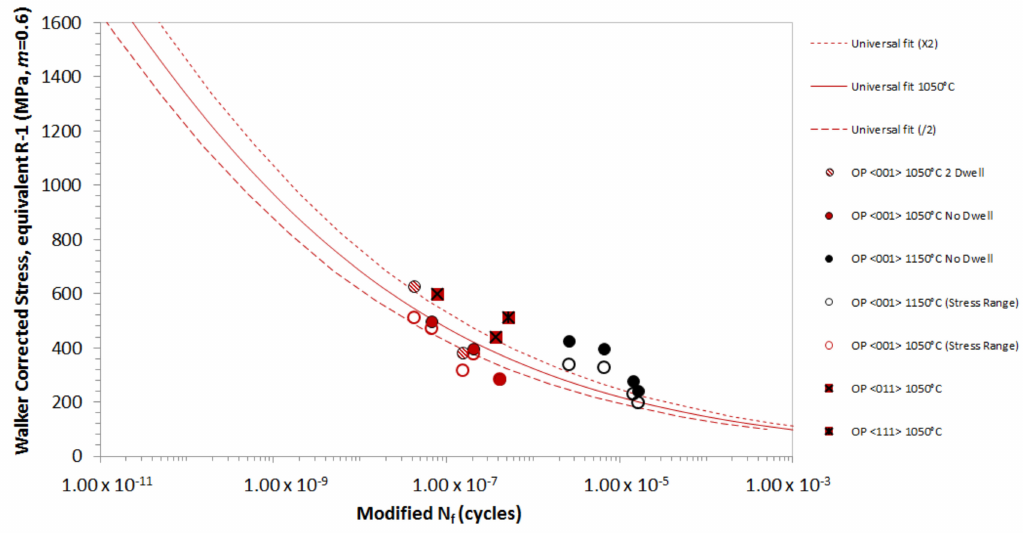
Figure 7. Effect of single crystal growth orientation on out-of-phase TMF